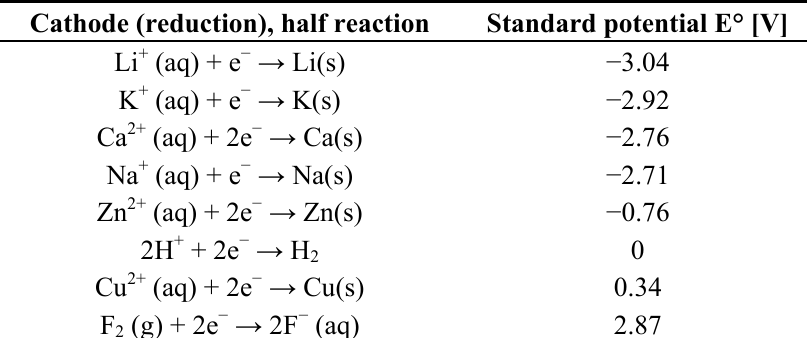
Table 1. Standard potential [35].